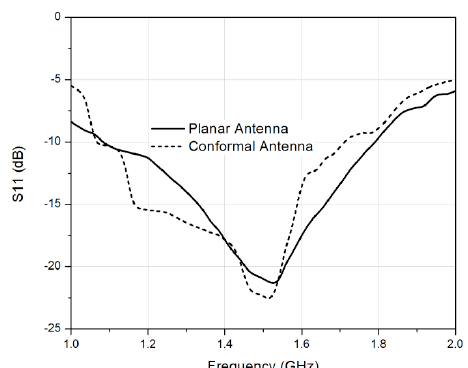
Figure 6: Photographs of fabricated antenna (a) Top view of Planar antenna (b) Bottom view of planar antenna (c) Top view of proposed conformal antenna with 60mm radius of curvature.